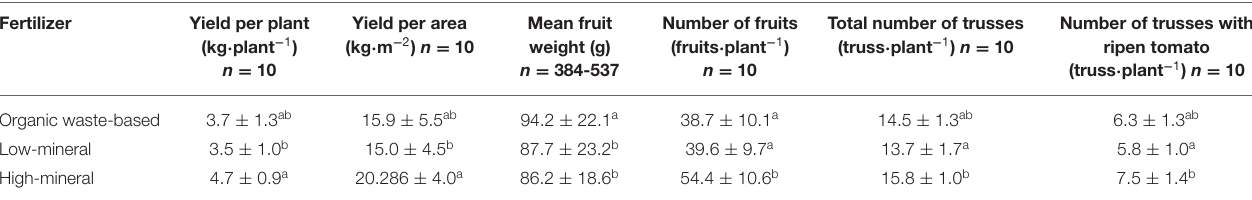
TABLE 2 | Commercial yield and yield components of tomato grown under different nutrient conditions.